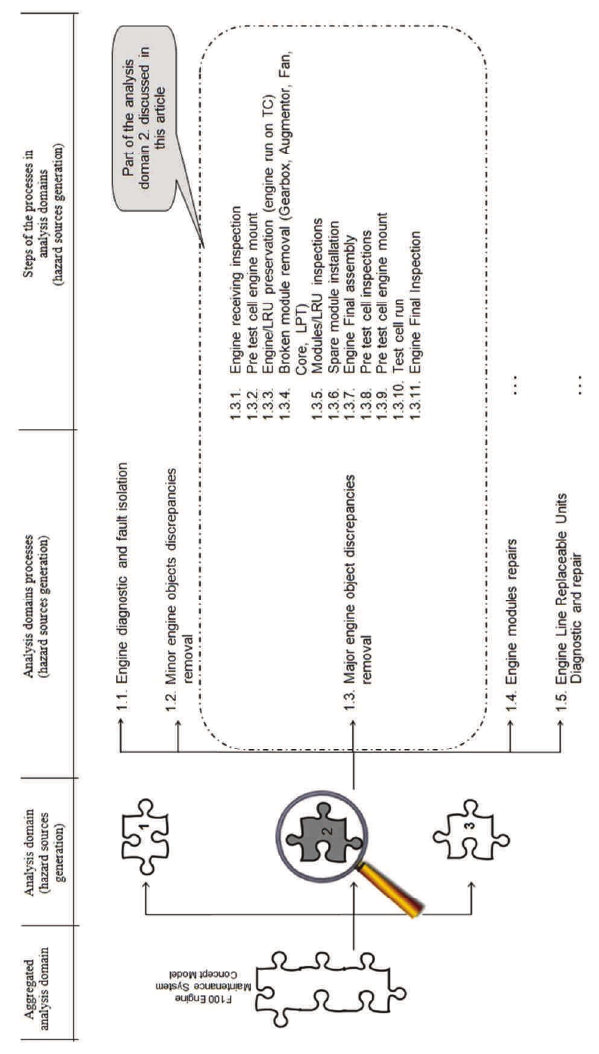
Fig. 6. Detailed schematic diagram of the aggregated analysis domain structure (detailed: Analysis domain 2. – Engine Intermediate